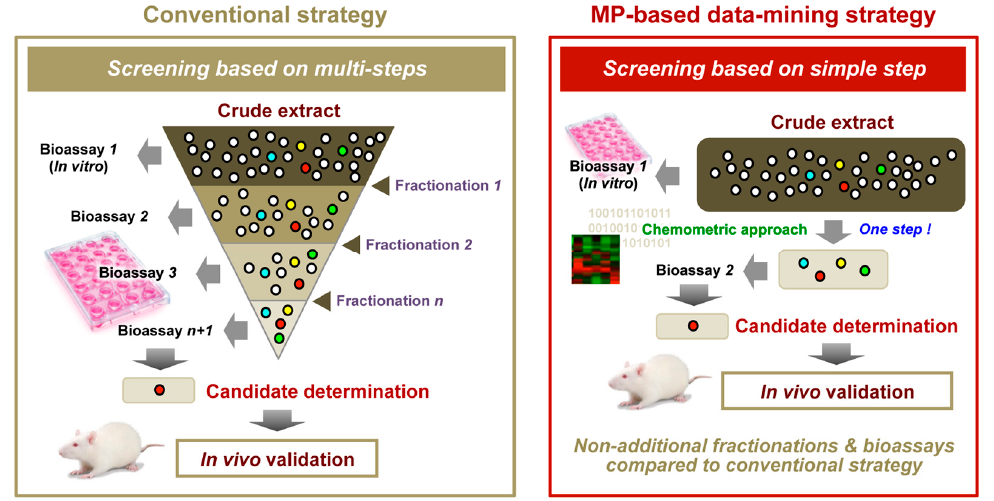
Figure 6. MP-based data-mining for an effective chemical combination. Adapted with permission from reference [116].